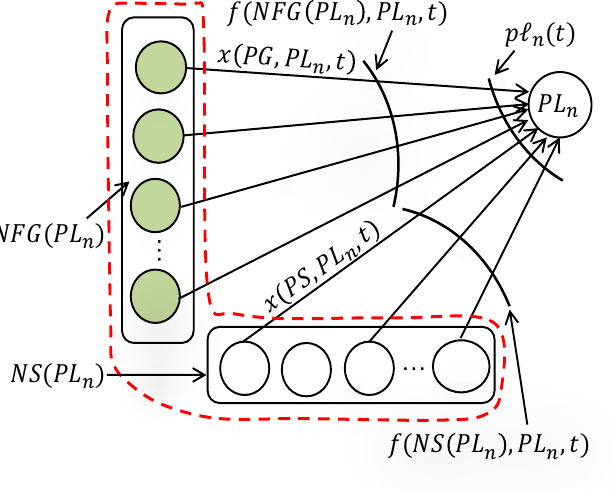
Figure 5. Connections between power loads and neighboring power